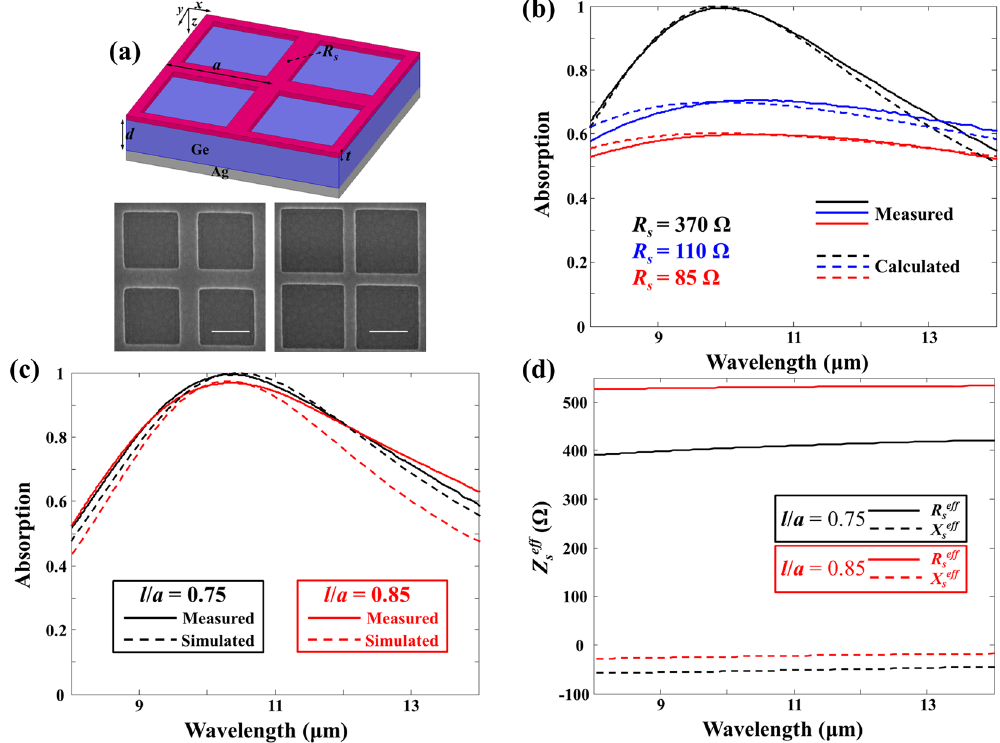
Figure 4. ( a ) Schematic and SEM images of the fabricated metasurface absorbers. Scale bar is 500 nm. ( b ) Measured (solid curves) and calculated (dashed curves) absorption spectral responses of Salisbury screen absorbers with three different surface resistances: R s = 85 (red curves), 110 (blue curves), and 370 Ω (black curves). ( c ) Measured (solid curves) and simulated (dashed curves) absorption spectral responses of the metasurface absorbers for l = 0.75 μ m with R s = 110 Ω (black curves) and l = 0.85 μ m with R s = 85 Ω (red curves). ( d ) Retrieved effective surface impedances of the metasurfaces for l = 0.75 μ m with R s = 110 Ω (black curves) and l = 0.85 μ m with R s = 85 Ω (red